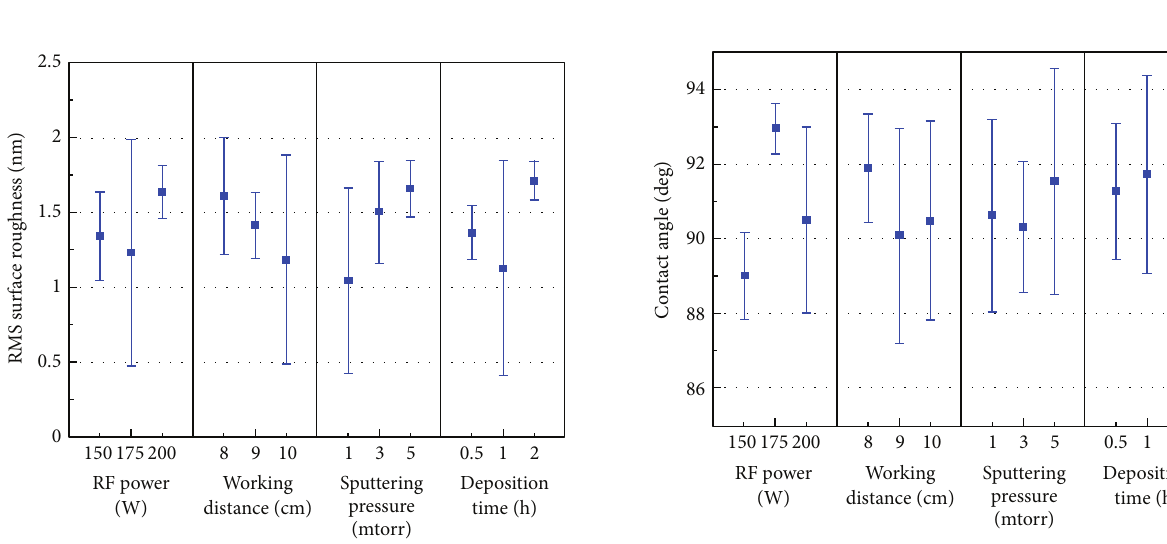
Figure 5: Response graph of four factors versus RMS surface roughness. The ranking order of the magnitude of RMS surface roughness at various levels indicates that the effects of various factors on the RMS surface roughness are ranked in the following order: sputtering pressure, deposition time, working distance, and RF power.